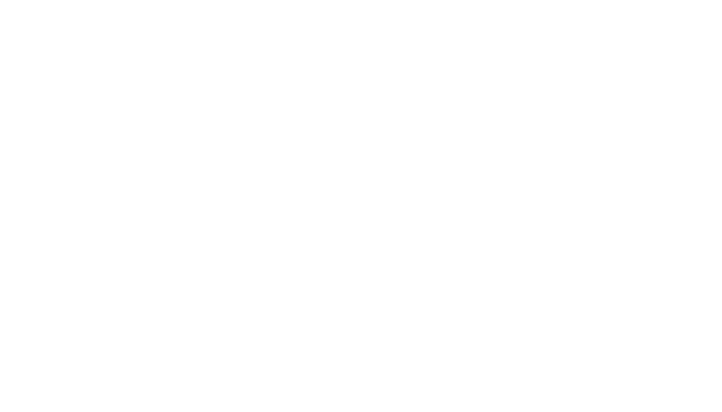
11 of 15 Figure 9. The scheme of the test model of the RRS SE on CPAW.